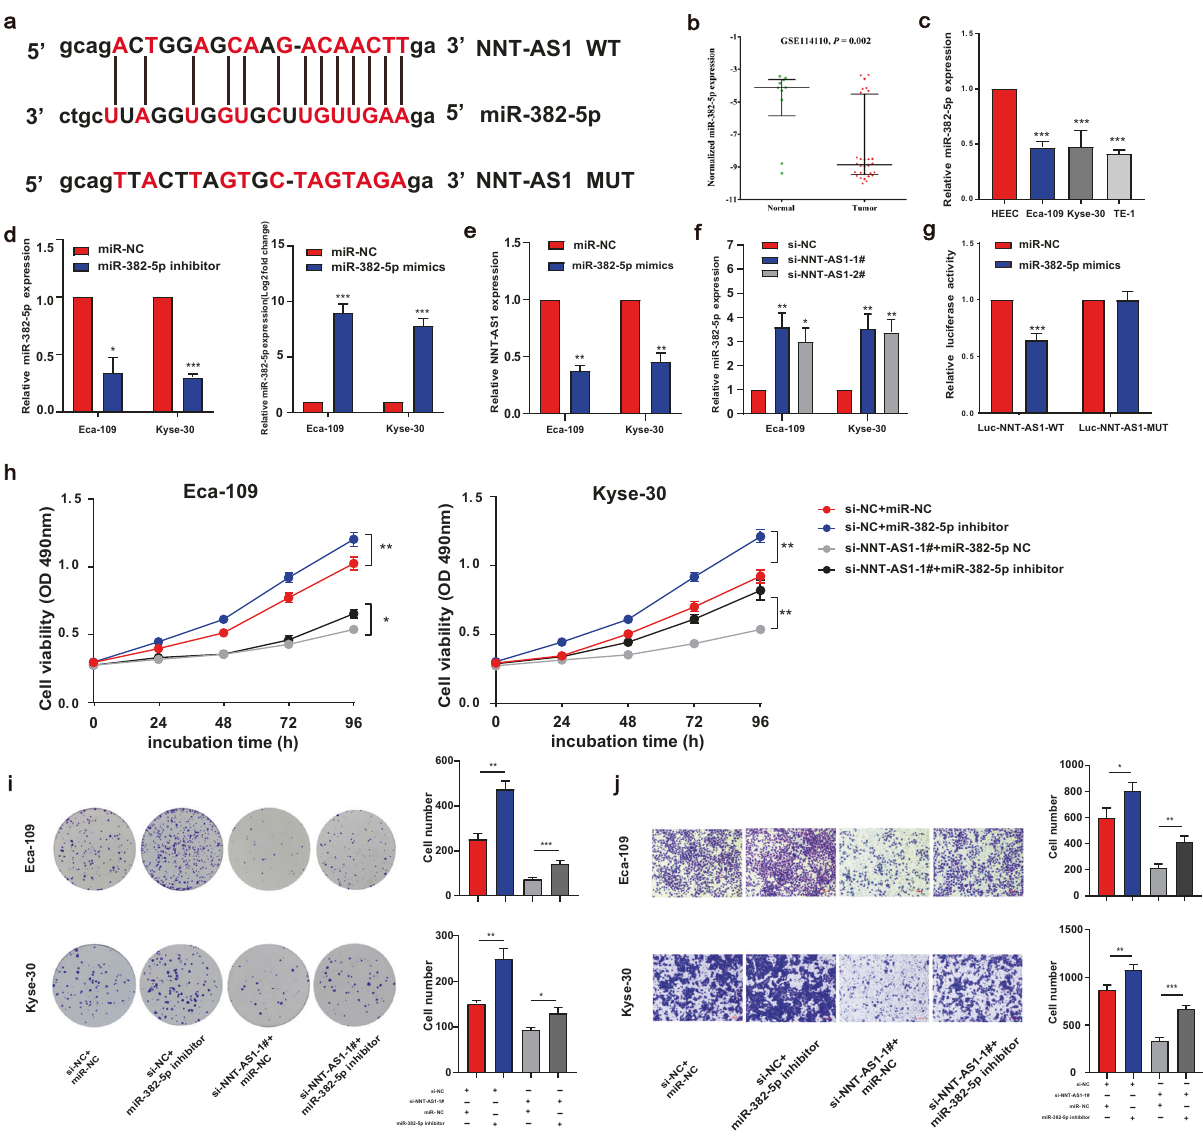
Fig. 5 NNT-AS1 could sponge miR-382-5p and knockdown of miR-382-5p could rescue the decreased ESCC proliferation and migration mediated by NNT-AS1 inhibition. a MiR-382-5p had a binding site for NNT-AS1; b MiR-382-5p was downregulated in ESCC tissues based on GSE114110 ( P = 0.002); c the expression of miR-382-5p in three ESCC cells and HEEC; d the transfection ef fi ciency of miR-382-5p mimics and inhibitor were veri fi ed; e overexpression of miR-382-5p inhibited the NNT-AS1 expression; f knockdown of NNT-AS1 increased miR-382-5p expression; g Dual-Luciferase assays detected the luciferase activities in Eca-109 cells after being co-transfected with miRNA (miR-NC or miR- mimics) and luciferase reporter vectors (NNT-AS1-WT or NNT-AS1-MUT); h – j MiR-382-5p partly retrieved the suppressed abilities of proliferation ( h MTT; i colony formation) and migration ( j ) that NNT-AS1 knockdown mediated in ESCC cell lines. The results were from three independent experiments. Data were analyzed by unpaired Student ’ s t -test. *** P < 0.001, ** P < 0.01, * P < 0.05. Variables were presented as the Mean ± fl uorescence Microscope and the graphs were captured simultaneously Colony forming assay 2 × 10 3 transfected cells were planted in a 6-well plate per well and from three random fi elds. The proliferation rate in EdU staining was incubated in a complete medium until the colonies could be detected by de fi ned as the percentage of EdU staining cells relative to cells stained naked eyes. Then the colonies were cleaned with normal saline and fi xed by DAPI. with 4% paraformaldehyde (room temperature, 15 min) followed by staining using 0.5% crystal violet staining (Beyotime, Shanghai, China). Transwell assay ImageJ software was used to detect the number of colonies. Transwell assays were carried out using Transwell apical chamber (Corning Life Sciences, Corning, NY, USA). In total, 5 × 10 4 transfected cells were added into the upper compartment, while 700 µl complete medium was injected into the lower part. After 24 h, cells were fi xed using 4% paraformaldehyde followed by staining with 0.5% crystal violet. Then, cells that failed to migrate to the outer surface of the upper compartment were scrubbed by cotton swabs. Five microscopic fi elds per chamber were